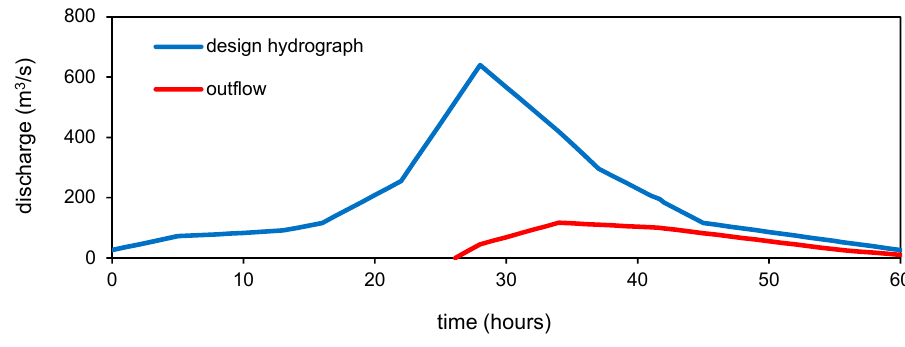
Figure 18. Design flood and outflow hydrographs.